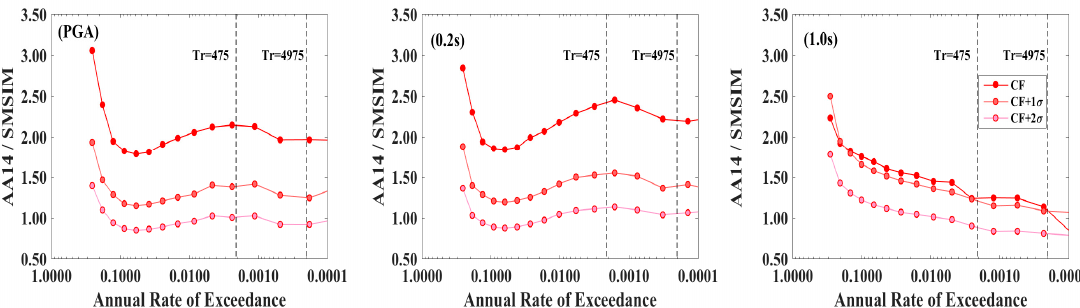
Figure 10. AA14 (2600 m/s)/SMSIM hazard curve ratios for three different spectral periods (PGA, left; 0.2 s, middle; 1.0 s, right), showing the fit of the hazard curve built from scaled stochastic time histories to the target hazard curve, using three different correction factors CF, CF+1 σ , and CF+2 σ . The best fit is obtained using the scaling factor CF+2 σ at all spectral periods.